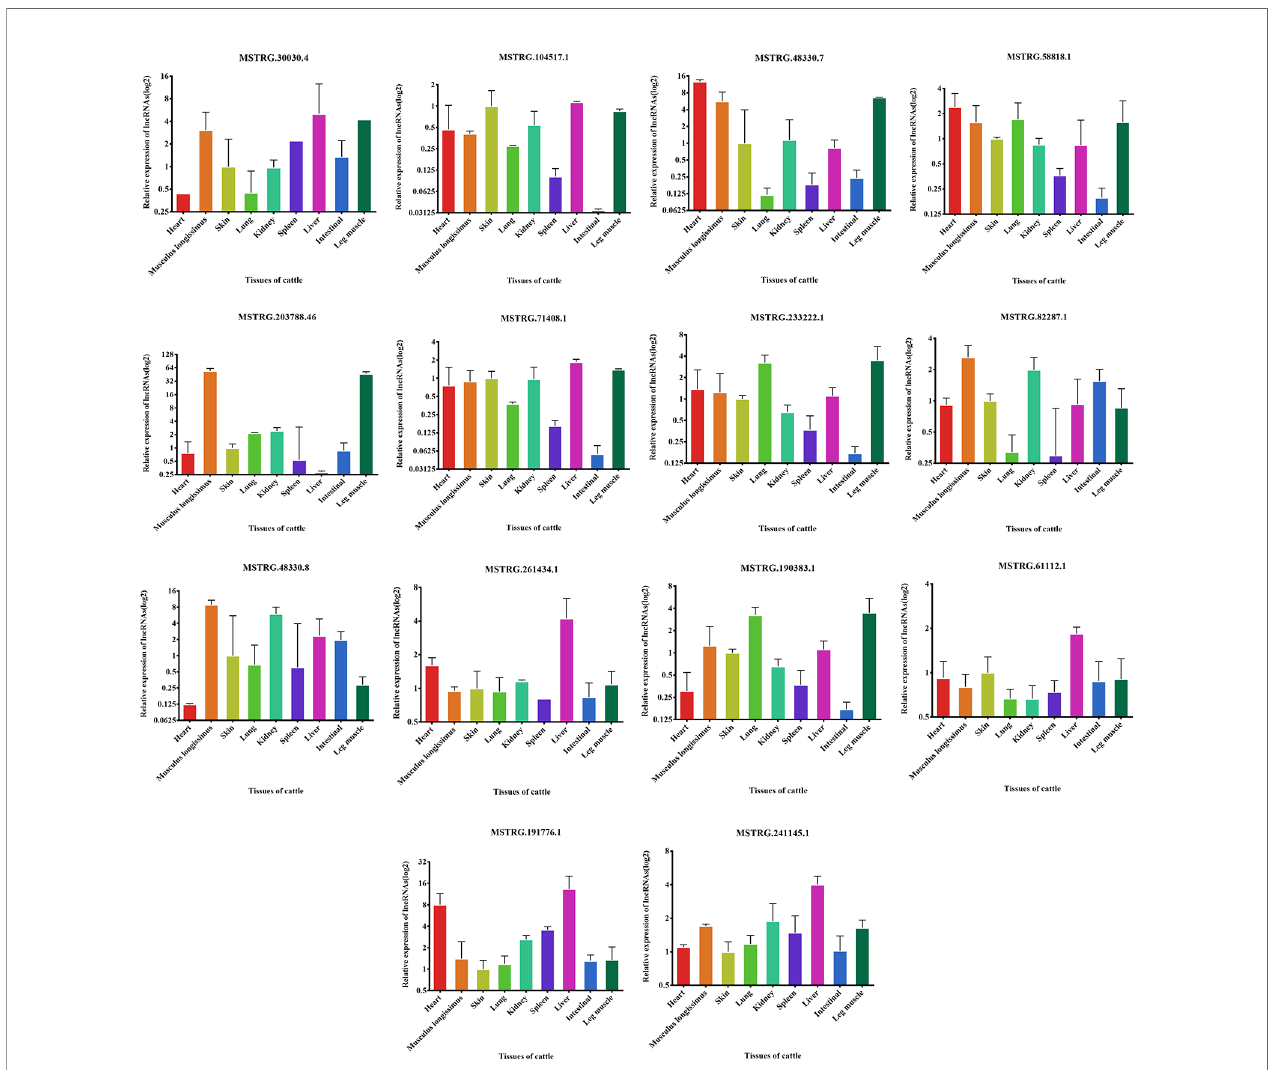
FIGURE 8 | Expression levels of 14 candidate lncRNAs in different tissues of fetus